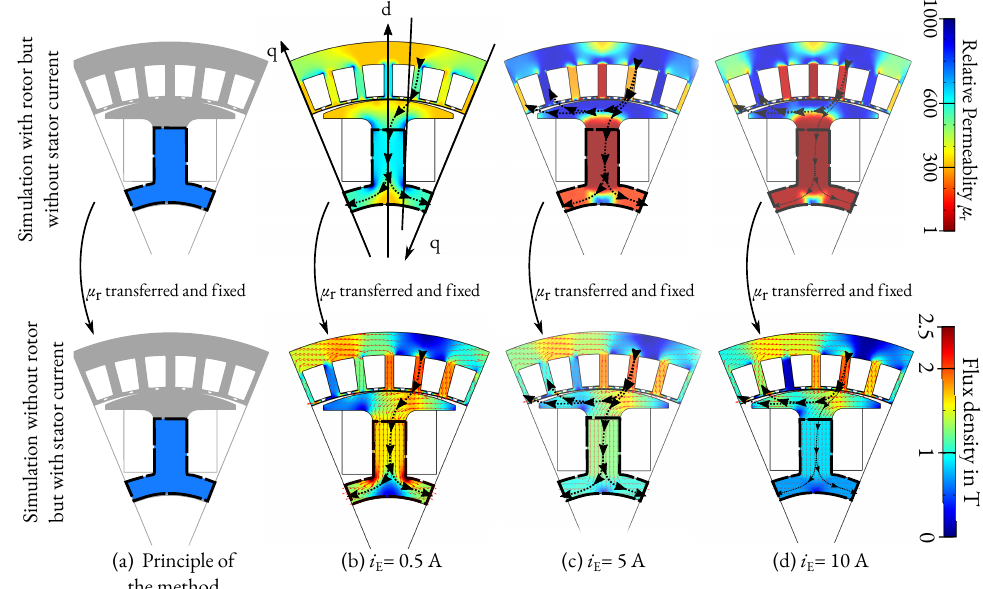
Figure 6. Simulation with frozen permeability method for different excitation currents. ( a ) Shows the principle of the method: simulations on the top are performed without stator current. The permeability in the marked region is frozen and used for the simulation with stator but without rotor current. ( b – d ) Shows the permeability of the iron without stator current (left) and the resulting flux i d = 150 A, i e = 0 A). On the bottom side, the flux density density considering stator current ( i q = − vector is plotted in red. Additionally, the preferred flux paths are highlighted with black